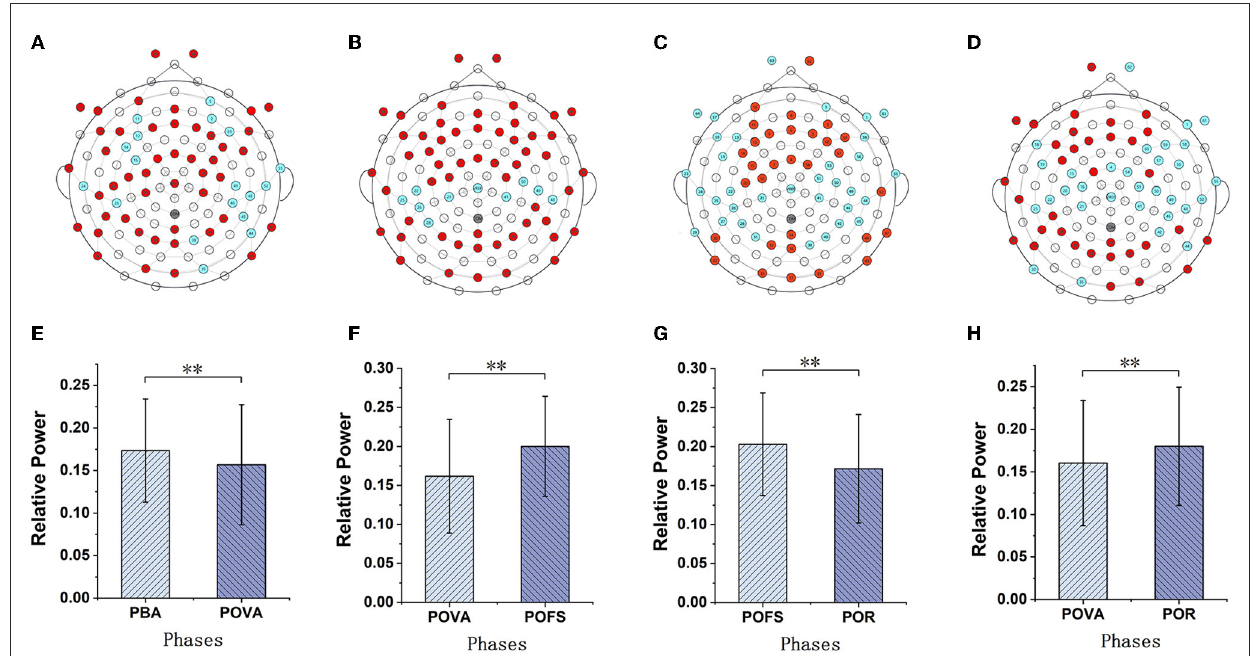
FIGURE5 The comparison of beta power in different phases. (A–D) are the brain topography distributions of selected channels in PBA and POVA comparison, POVA and POFS comparison, POFS and POR comparison, and POVA and POR comparison, respectively. In the brain topography, the red dots are channels with significant differences between the two comparisons, the blue dots are channels without significant differences, and the white dots are empty channels. Mean relative power changes according to the selected channels shown in red in (A–D) for the PBA and POVA comparison, POVA and POFS comparison, POFS and POR comparison, and POVA and POR comparison are shown in (E–H) , respectively. ** p < 0.01.